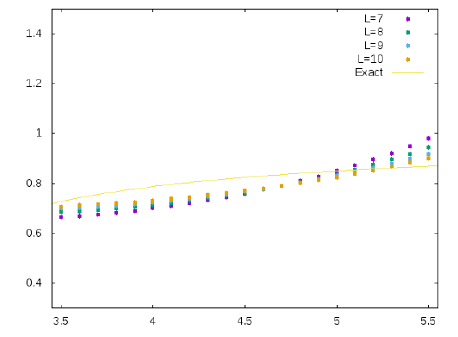
Figure 9 . The critical exponent plotted vs. k , using the values r = 2 : 1 and j = 1 in the blob sector.